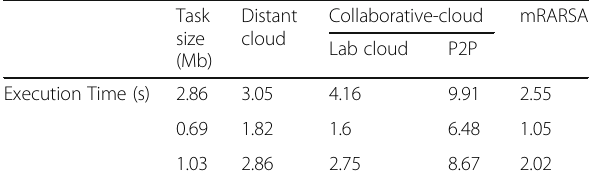
Table 8 Execution time performance evaluation